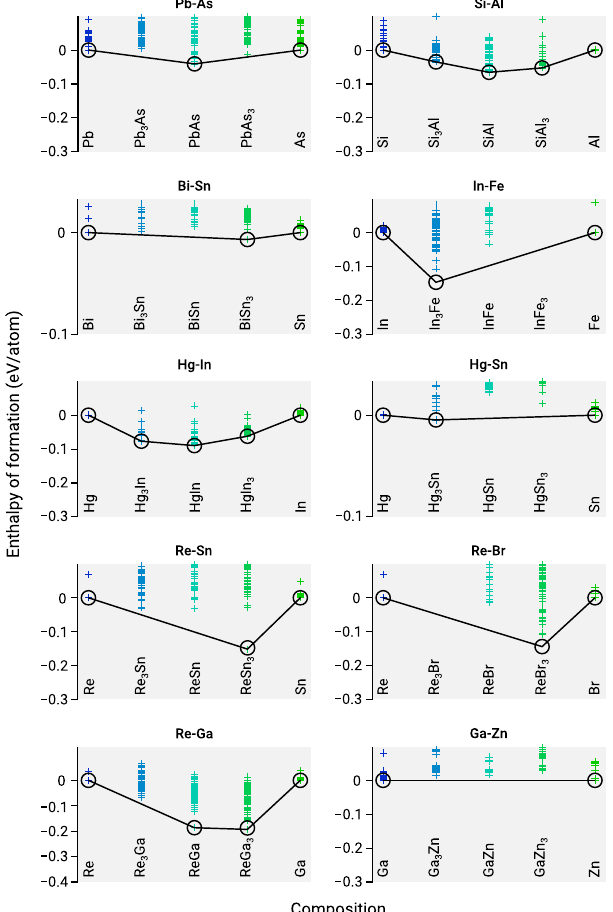
FIG. 7. The convex hulls of formation enthalpy of ten ambient- immiscible binary systems calculated using structural search at 50 GPa via the MHM. Each cross denotes a phase sampled with the MHM. In all but the Zn-Ga system, we find at least one thermodynamically stable high-pressure